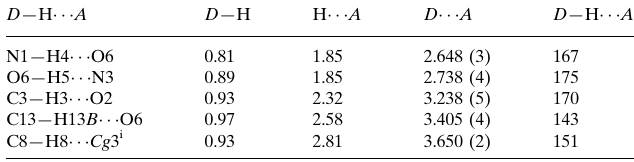
Hydrogen-bond geometry (A˚ , (cid:3)